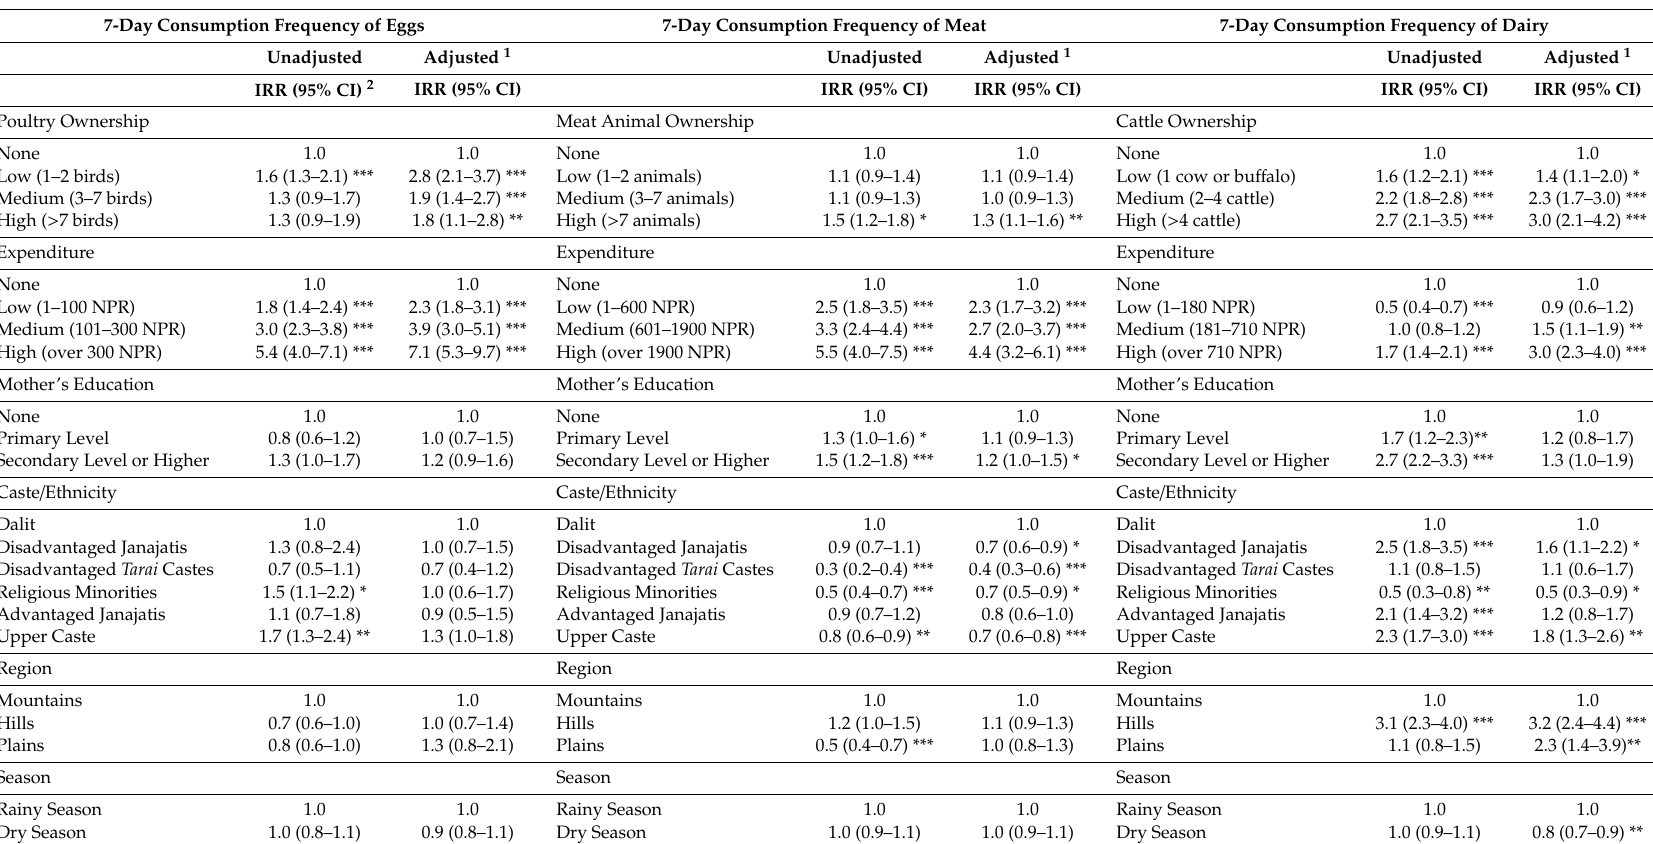
Table 2. Unadjusted and adjusted negative binomial generalized estimating equation regression results for analyses of the relationship between household livestock ownership and children’s animal source food consumption in 485 Nepali farming households observed at up to 4 timepoints ( n = 1449